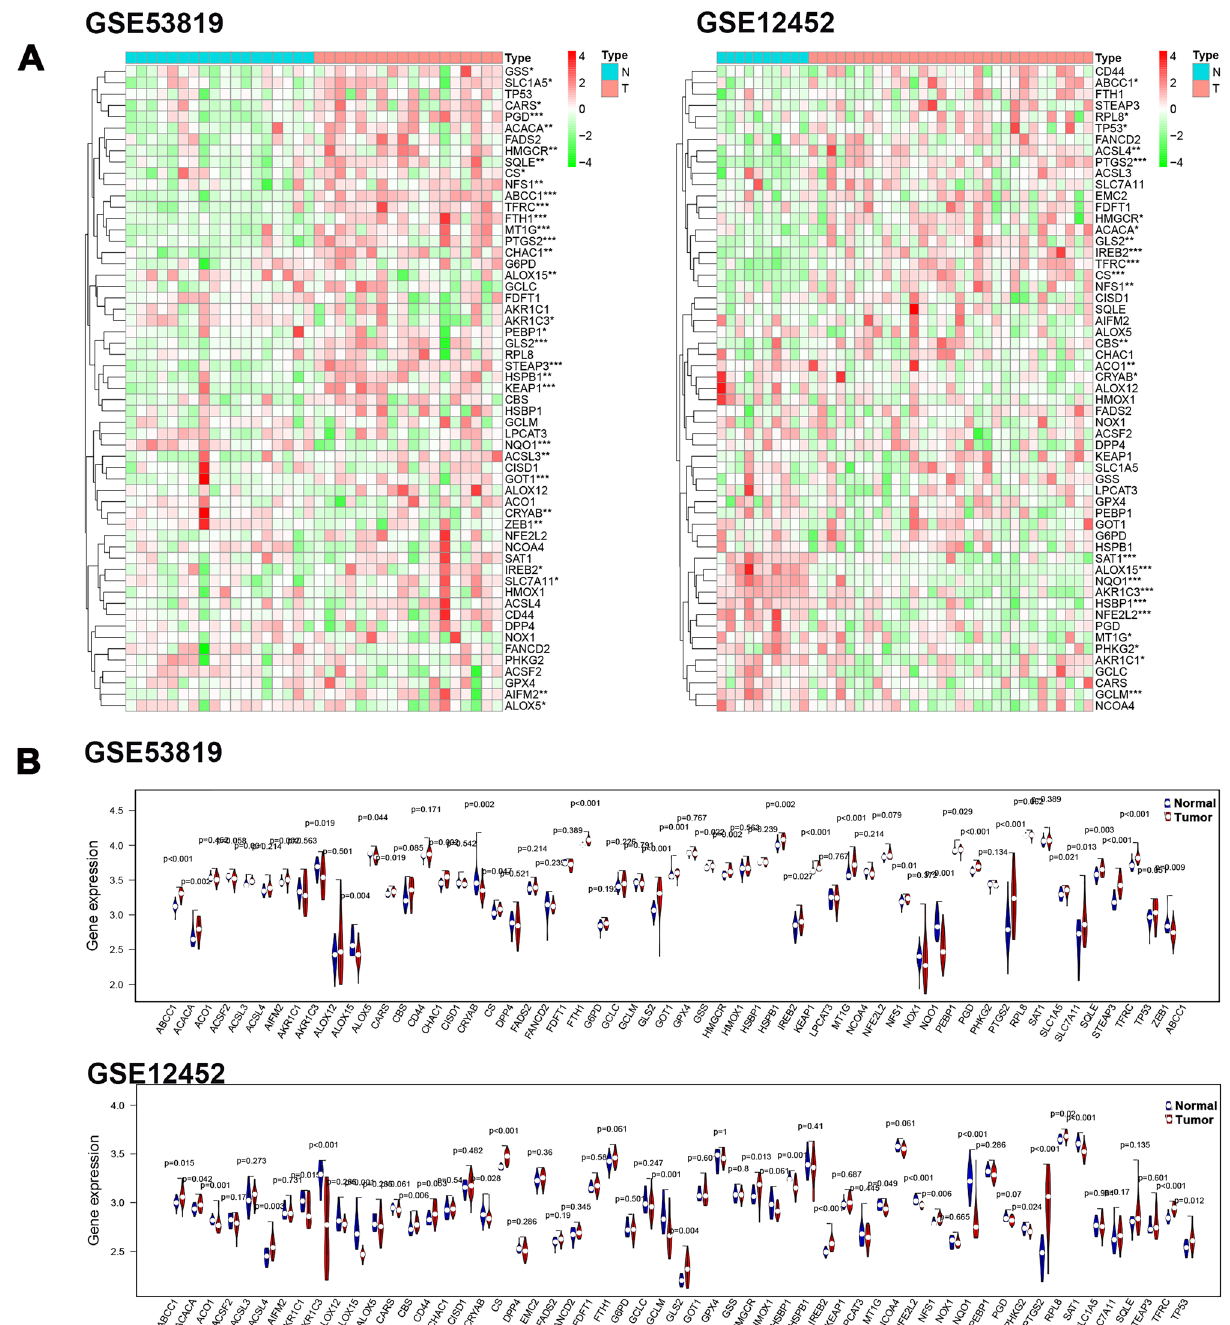
Figure 1. The expression profiles of FRGs in NPC. ( A ) The heatmap of DE_FRGs in GSE53819 and GSE12452 using “edgeR” package (version 4.0.5, https:// cran.r- proje ct. org/). ( B ) The gene expression levels of FRGs in GSE53819 and GSE12452 from GEO (https:// www. ncbi. nlm. nih. gov/